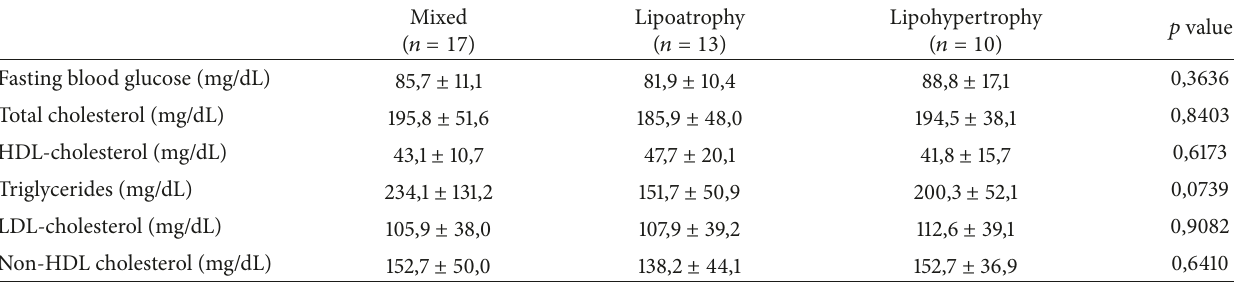
Table 6: Metabolic profile of people living with HIV/AIDS separated by HIV-associated lipodystrophy syndrome subtype.